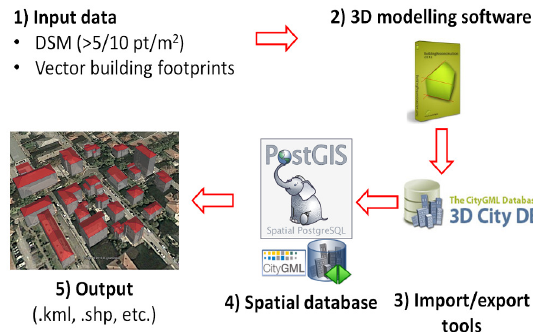
Figure 5 Schematic representation of the steps required to reconstruct the 3D building geometries starting from a DSM and the vector-based building footprints.